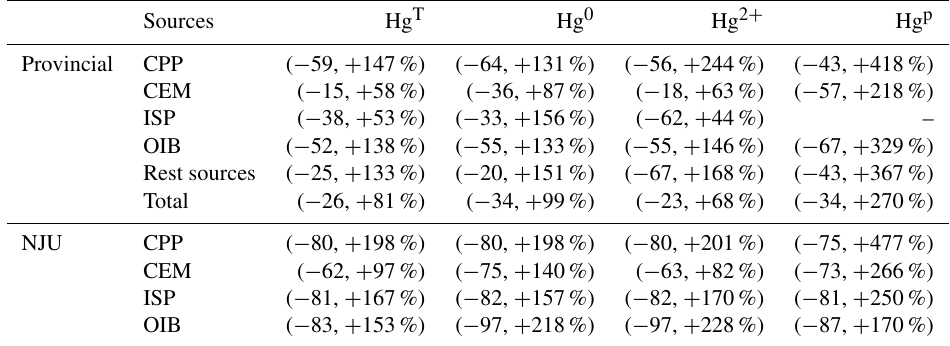
Table 4. Uncertainties in Hg emissions in Jiangsu in provincial and national (NJU) inventories by source, expressed as the 95% confidence intervals of central